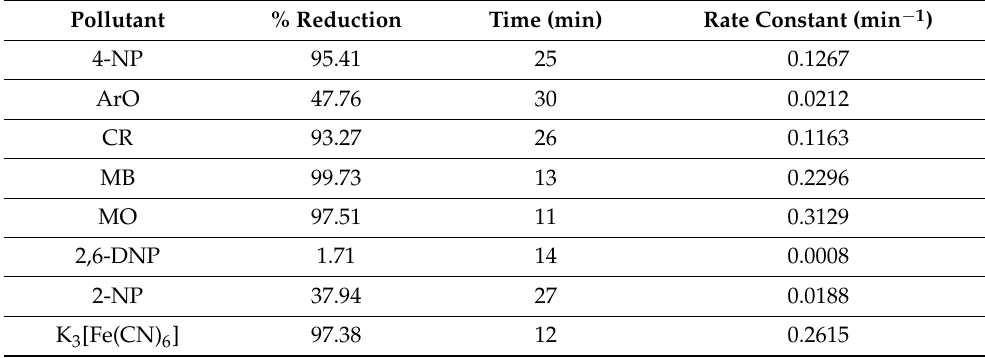
Table 1. Characteristics of catalytic reduction of studied pollutants using NaBH 4 and four beads of Cu@Alg/Co–CeO 2